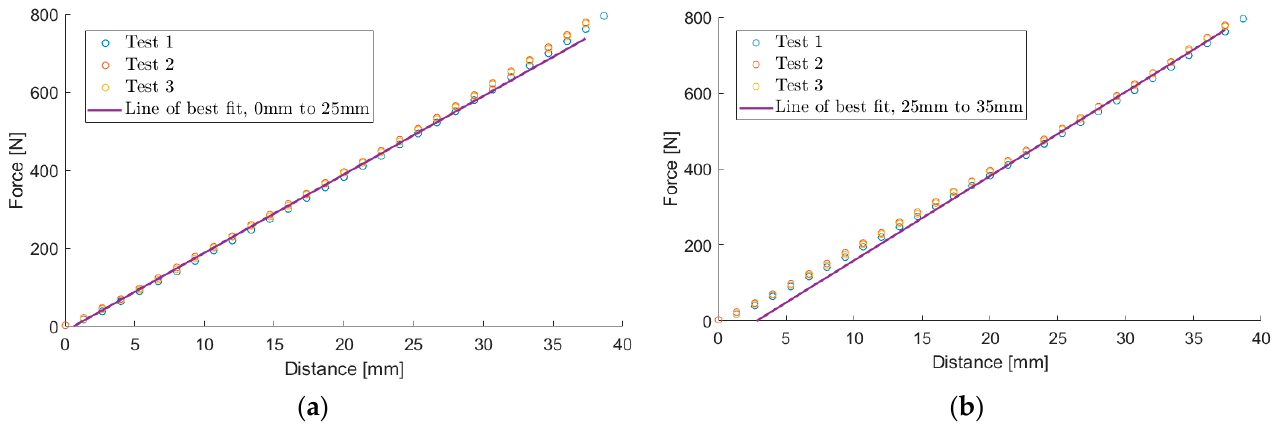
Figure 6. Spring stiffness of vertical springs in Half 1 of the 2DOF system. Spring stiffness approxi- mated based on a line of best fit evaluated from ( a ) 0 to 25 mm, obtaining an average stiffness of 20.07 N/mm; ( b ) 25 to 35 mm, obtaining an average stiffness of 22.21 N/mm.